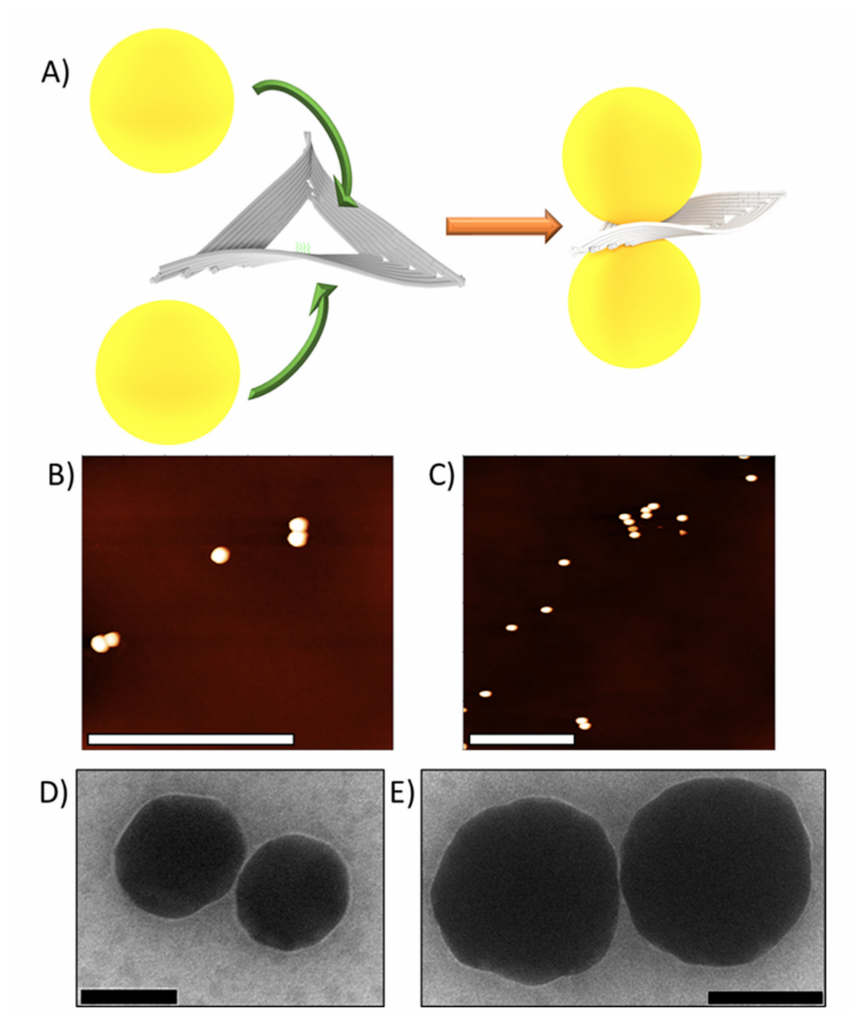
Figure 2. ( A ) Scheme of the assembly of the nanoparticle dimers employing a DNA origami nanotri- angle with sticky ends positioned on opposite sites. Two DNA-modified nanoparticles are inserted that hybridize into nanoparticle dimers with the nanotriangle in between the nanoparticles. ( B ) AFM image showing 60 nm AuNP dimers, and ( C ) AFM image showing the 80 nm AuNP dimers. Both on C and D the images show that the samples are a mixture of single nanoparticles, dimers, and small nanoparticle aggregates. On both images, the scale bar is 1 µ m long. ( D , E ) Representative TEM images of the 60 nm and 80 nm AuNP dimers, scale bars are 50 nm